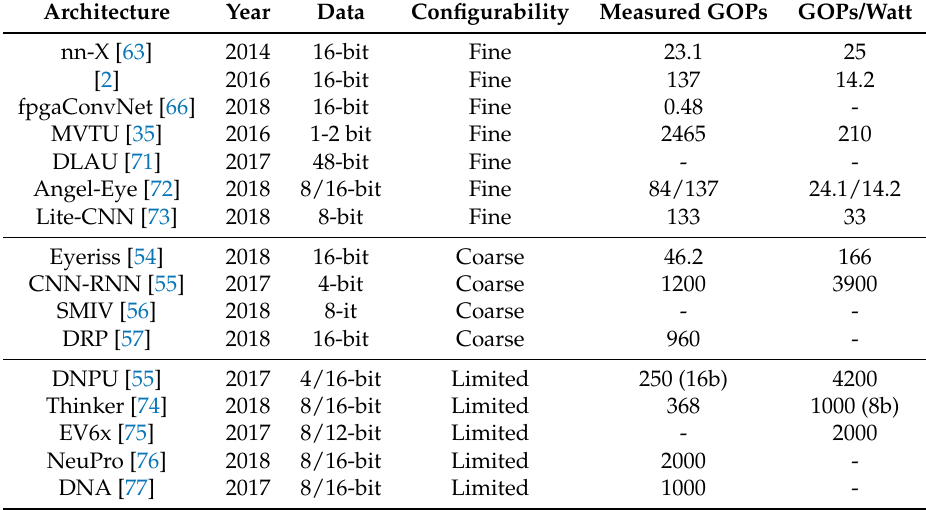
Table 3. Main features of reconfigurable and configurable architectures for deep neural networks on the